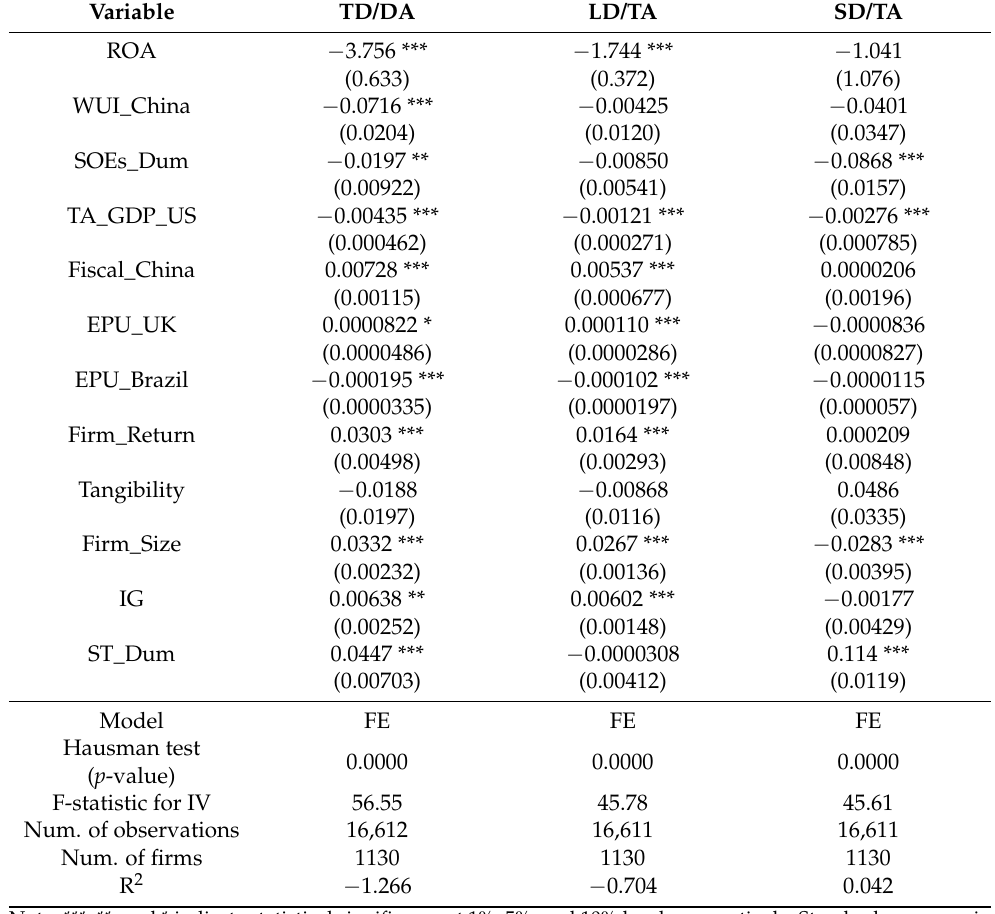
Table 6. The impacts of the economic uncertainty on capital structure: robustness